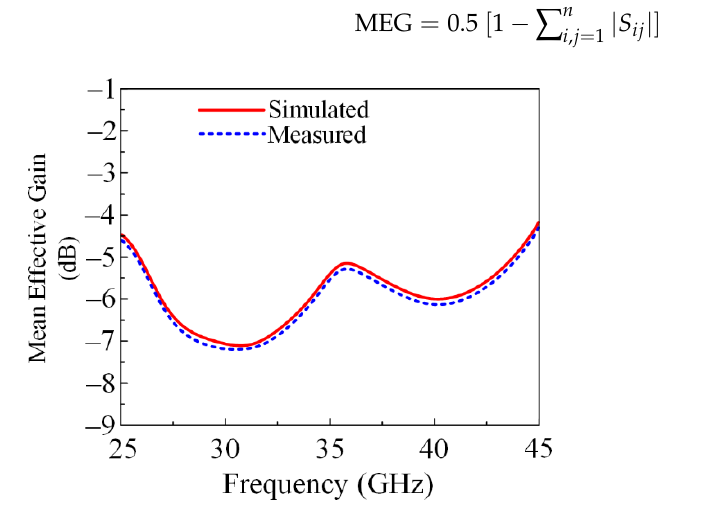
Figure 16. Mean Effective Gain (MEG) of the proposed parasitic element-loaded dual-band MIMO antenna.